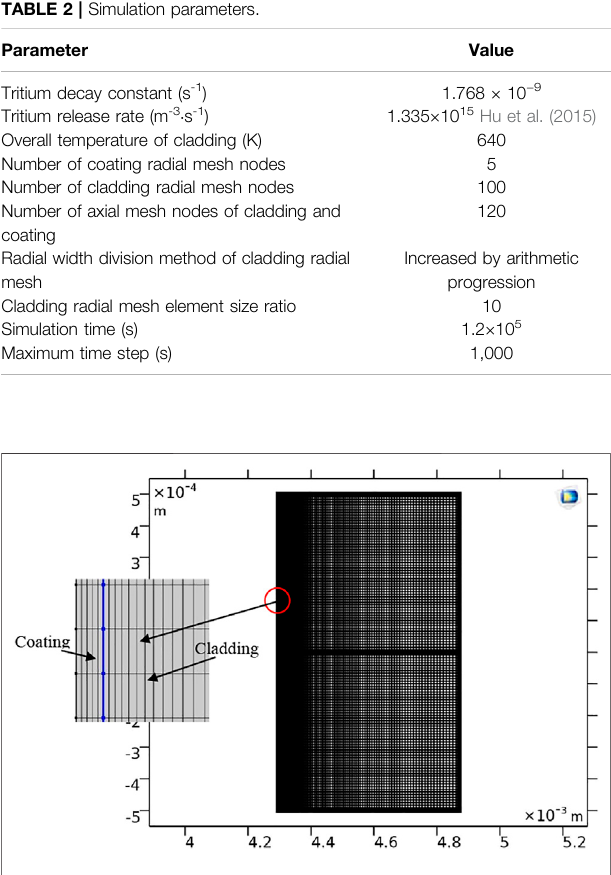
FIGURE 9 | The computational mesh of FeCrAl cladding with coating.